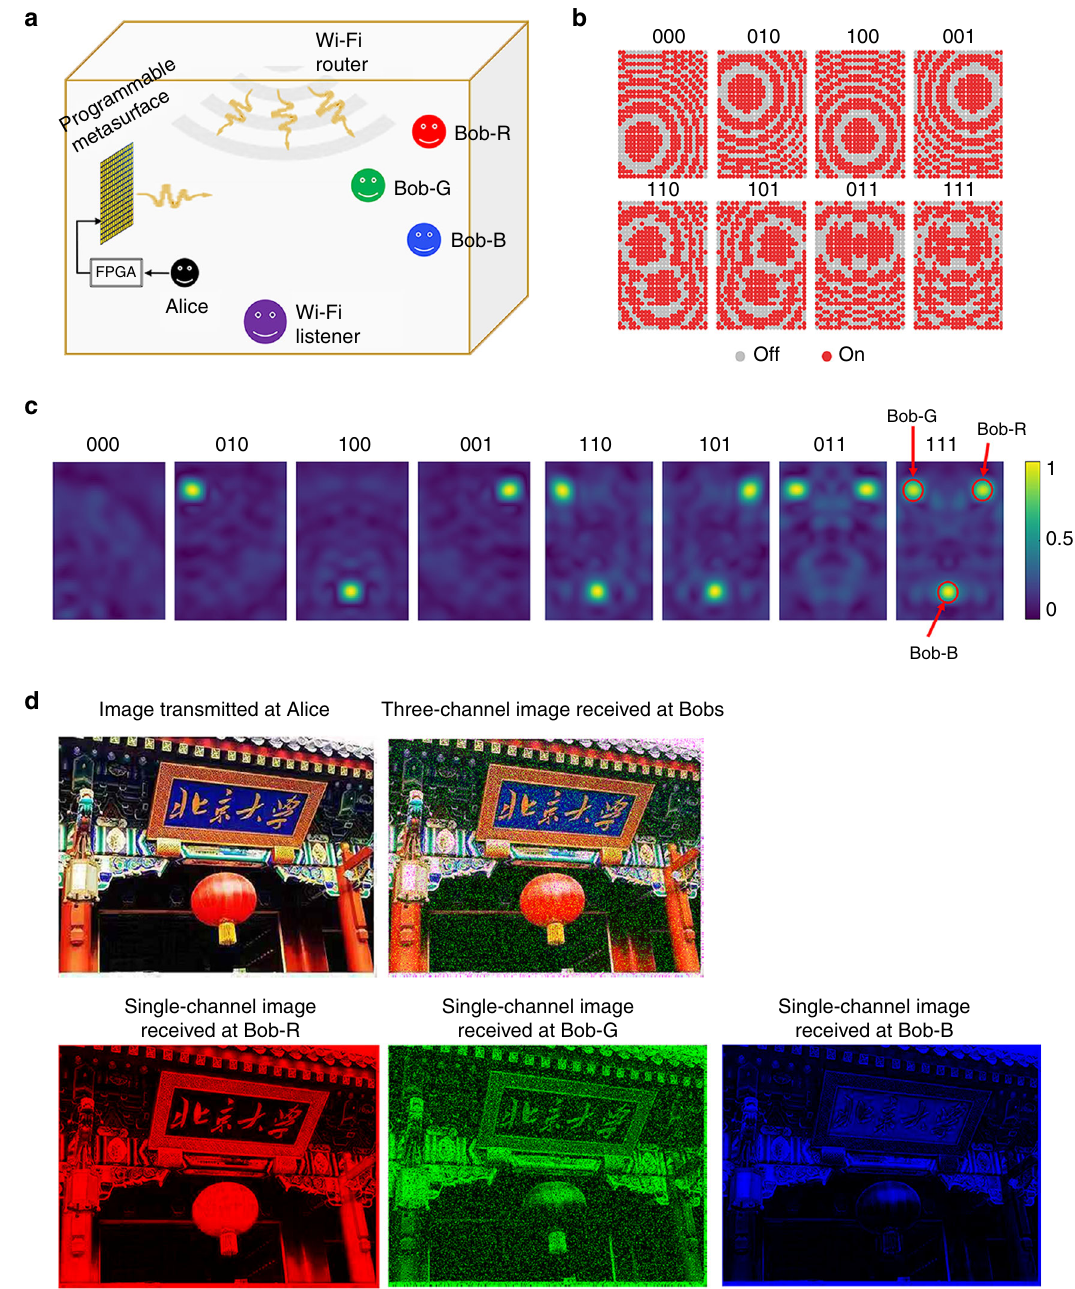
Fig. 3 Results of the three-channel BASK MBWC. a Schematic of the experimental setup considering a scenario with commodity Wi-Fi signals in an indoor environment. A 2.412 GHz Wi-Fi router located at an arbitrary location emits radio waves, which are captured by a standard AWC Wi-Fi user ( “ listener ” ). Alice transmits her three direction-dependent streams of information to three independent users, i.e., Bob-R ( − 0.86, 0, 3 m), Bob-G (0.81, 0.648, 3 m), and Bob-B (0.81, − 0.648, and 3 m), by encoding the information into the programmable metasurface, and using it to modulate the stray Wi-Fi waves. The three independent users are located at a distance z = 3 m away from the metasurface. b Optimized control coding patterns for the three-channel MBWC- BASK. c Simulated distributions of j H s ! meta ! mr j , corresponding to the eight coding patterns plotted in ( b ) for 2.412 GHz at the distance of z = 3 m from the metasurface. The intensity of stray Wi-Fi signals is well controlled for the purpose of passive amplitude modulation. d Individual images retrieved by Bob-R, Bob-G, and Bob-B. In addition, the full-color image transmitted by Alice, and the one synthetized using Bob ’ s results are